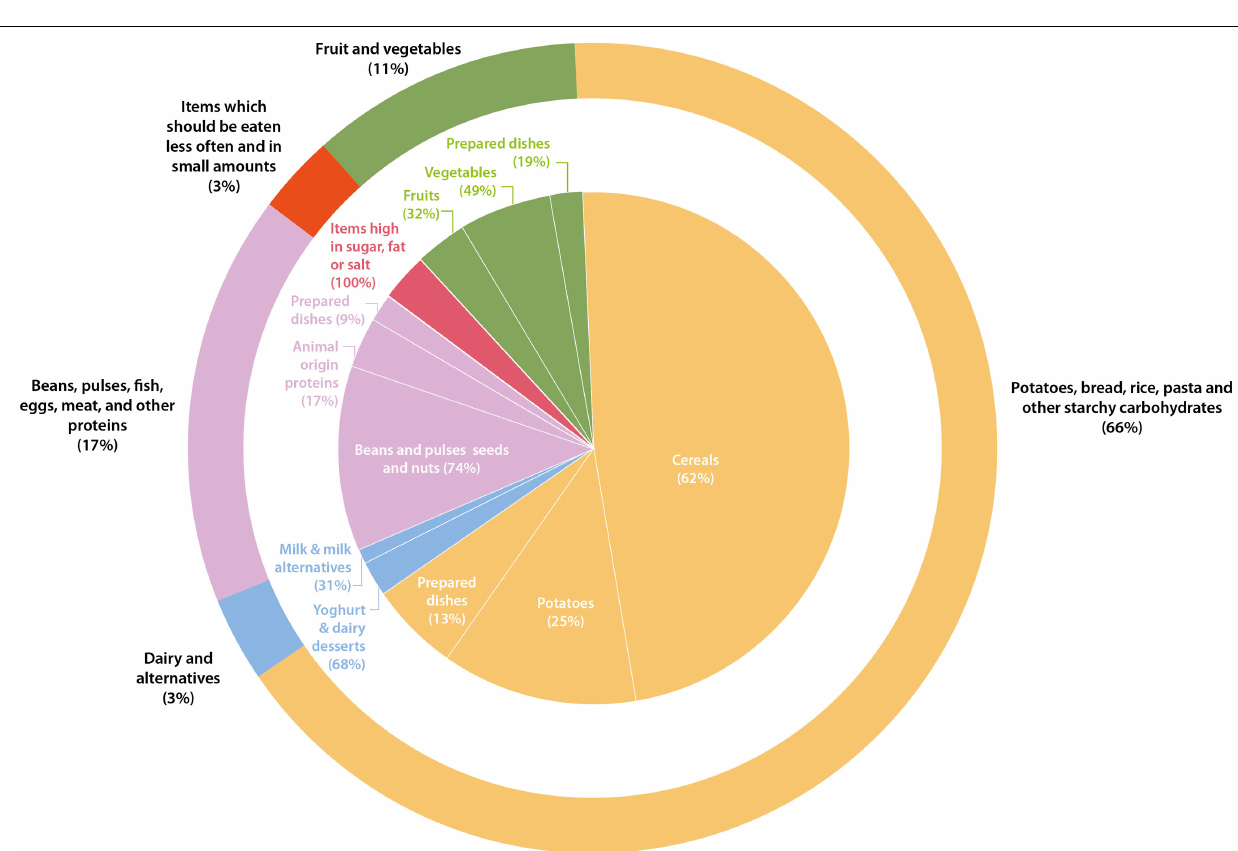
FIGURE 2 | Food groups designated following the Eatwell Guide groups. Each food scored 1 point if its GHGE was under the median, 1 point if its price was under the median, and 1 point if its nutritional score was above the median for the relevant food group. This graph shows those items with the highest score (scoring 3) and showcase the most environmentally sustainable, nutritious, and lower price products per every 100 kcal. The outer graphs show the overall percentages, and the inner graph subdivides the information per food